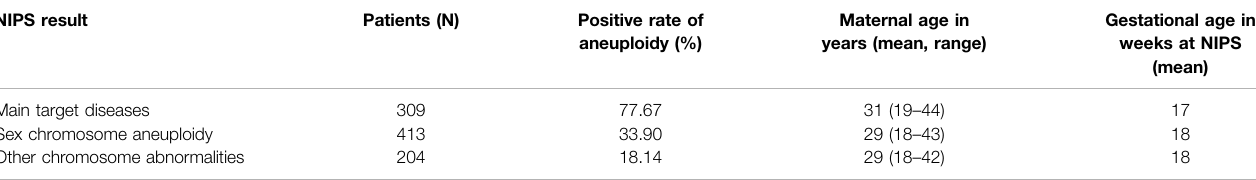
TABLE 1 | Summary statistics of 926 patients with positive NIPS